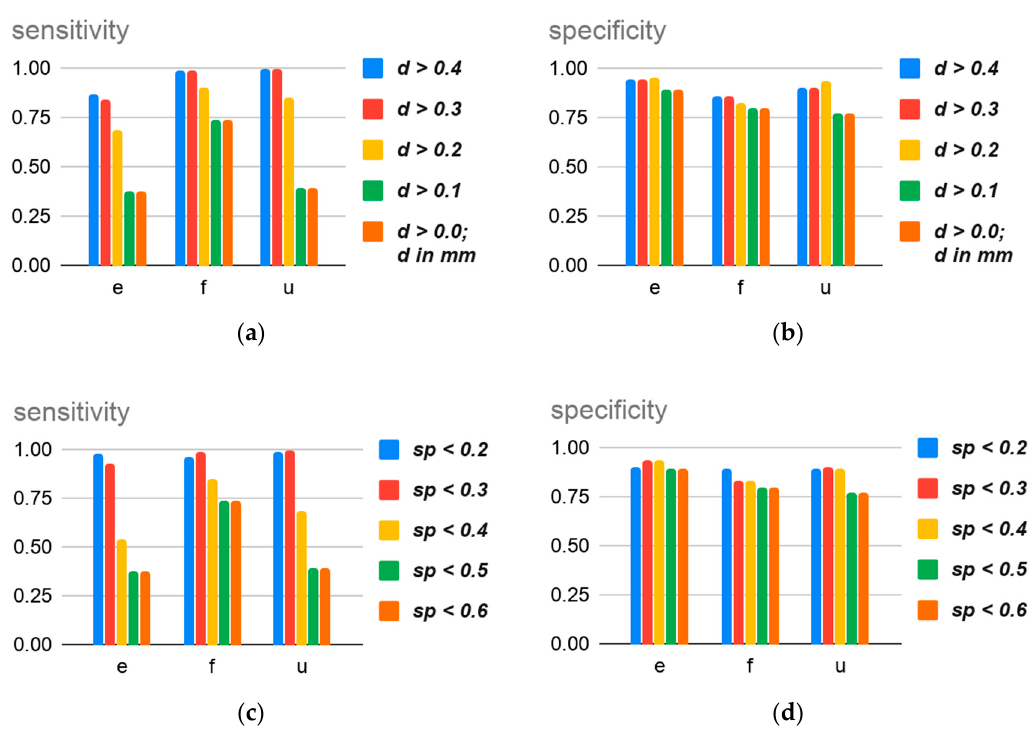
Figure 8. Sensitivity and specificity calculated for an angle range of | α − µ ( α ) | < s ( α ) of minimum d ( a , b ) and maximum sp ( c , d ), for each collections of voids by built direction .